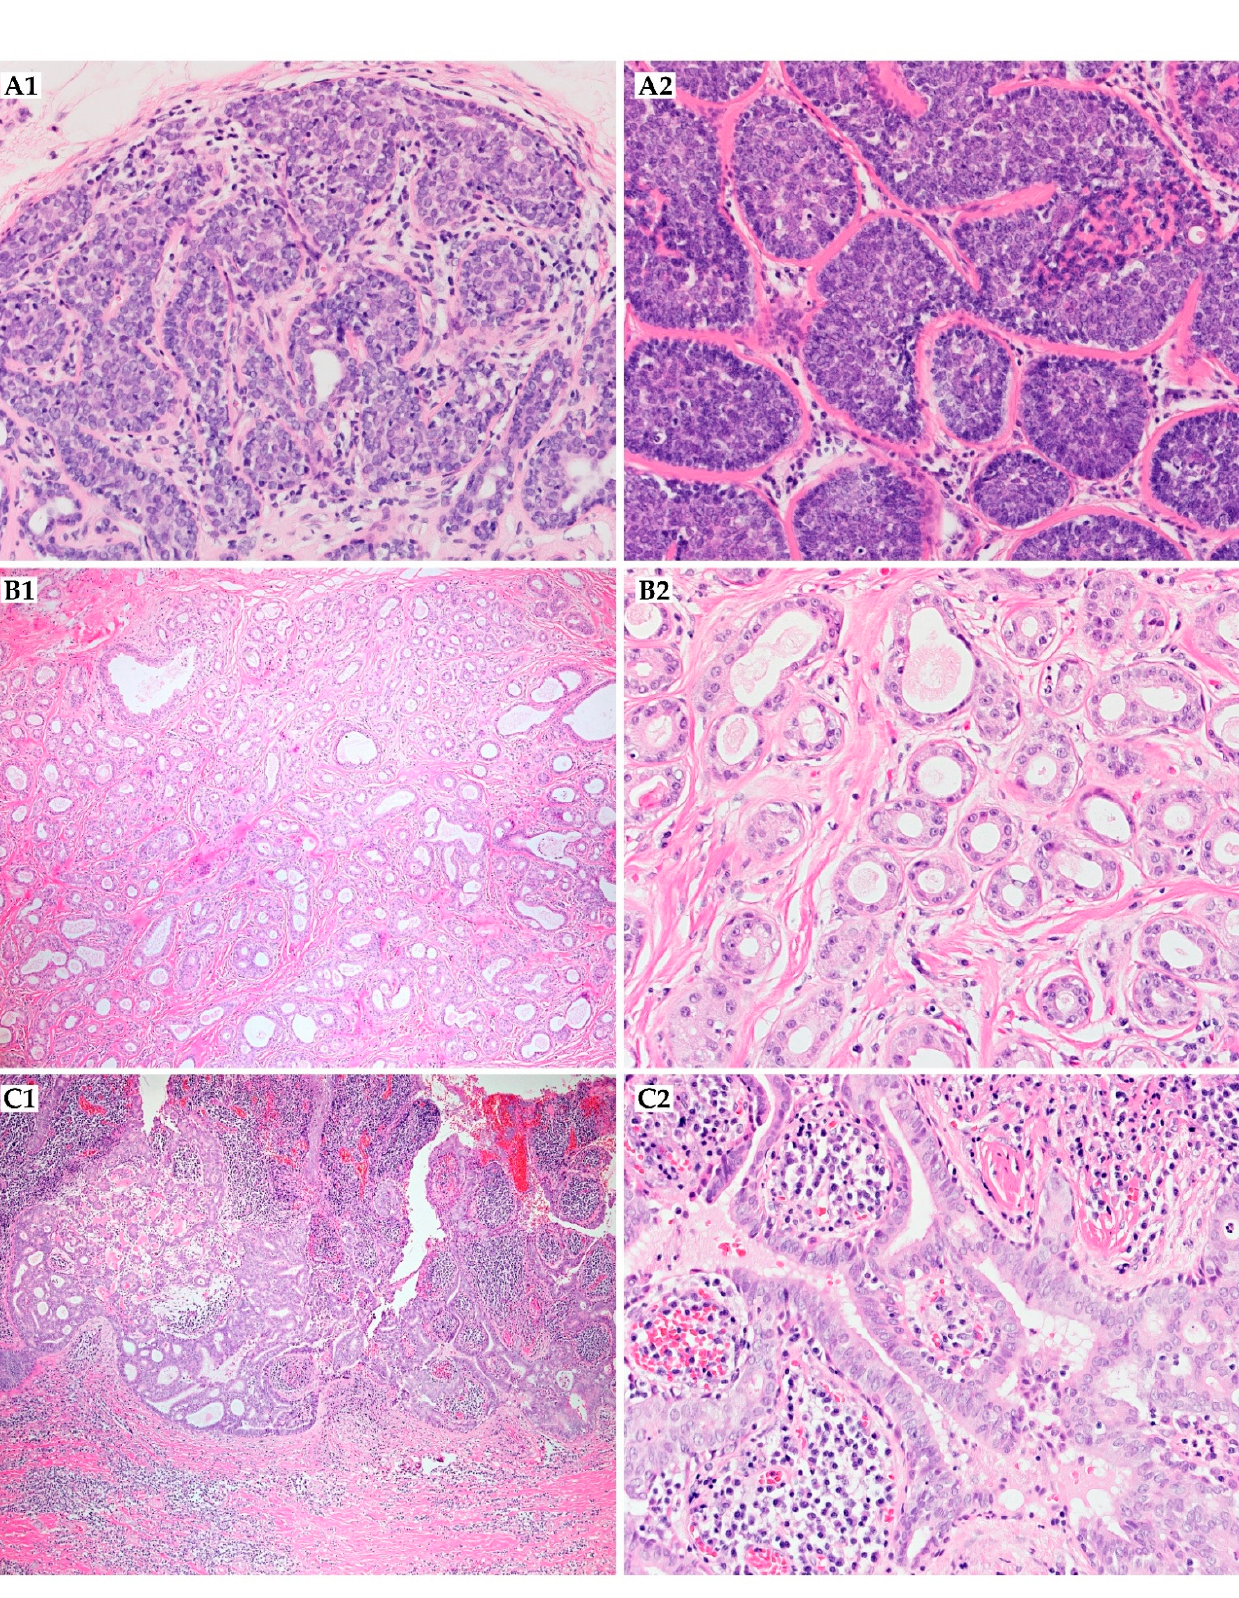
Figure 8. Benign tumors with apocrine or eccrine differentiation II. ( A1 ) (100 × , HE) and ( A2 ) (200 × , HE): Cylindroma, microscopic mosaic pattern with the jigsaw puzzle arrangement and surrounding of the prominent basement membrane. ( B1 ) (20 × , HE) and ( B2 ) (200 × , HE): Tubular adenoma composed of tubules and cystic structures. ( C1 ) (20 × , HE) and ( C2 ) (200 × , HE): Syringocystadenoma papilliferum consisting of two layers of apocrine cells which are forming papillary projec- tions.